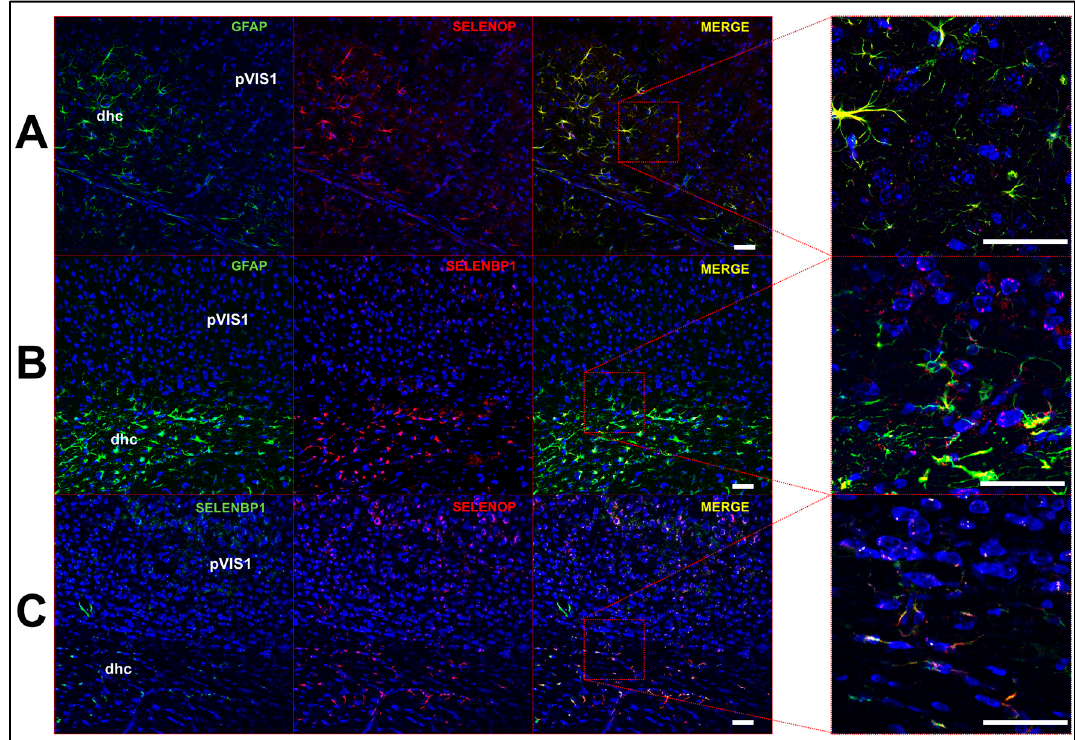
Figure 3. Astrocytes co-express selenoprotein P (SELENOP) and selenium binding protein 1 (SELENBP1). (A) Confocal images showing expression of GFAP (left), SELENOP (middle left), and merged images at low (middle right) and high magnification (right). (B) Images of GFAP (left), SELENBP1 (middle left), and merged images at low (middle right) and high magnification (right). (C) Images of SELENBP1 (left), SELENOP (middle left), and merged images at low (middle right) and high magnification (right). Abbreviations: dhc: dorsal hippocampal commisure; pVIS1: primary visual cortex. Scale bar = 50 μ m.